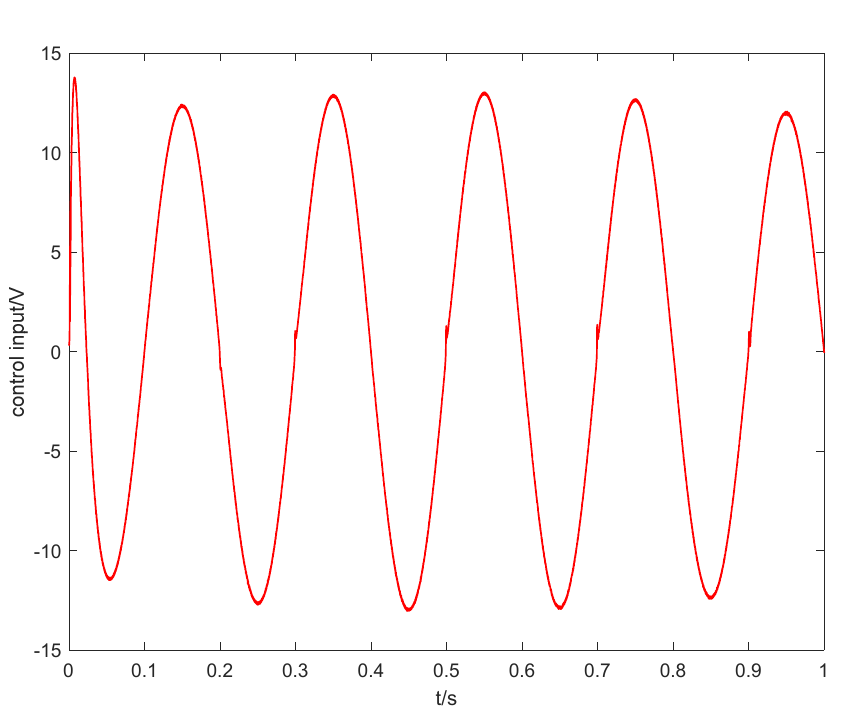
Figure 9. System control input curve.